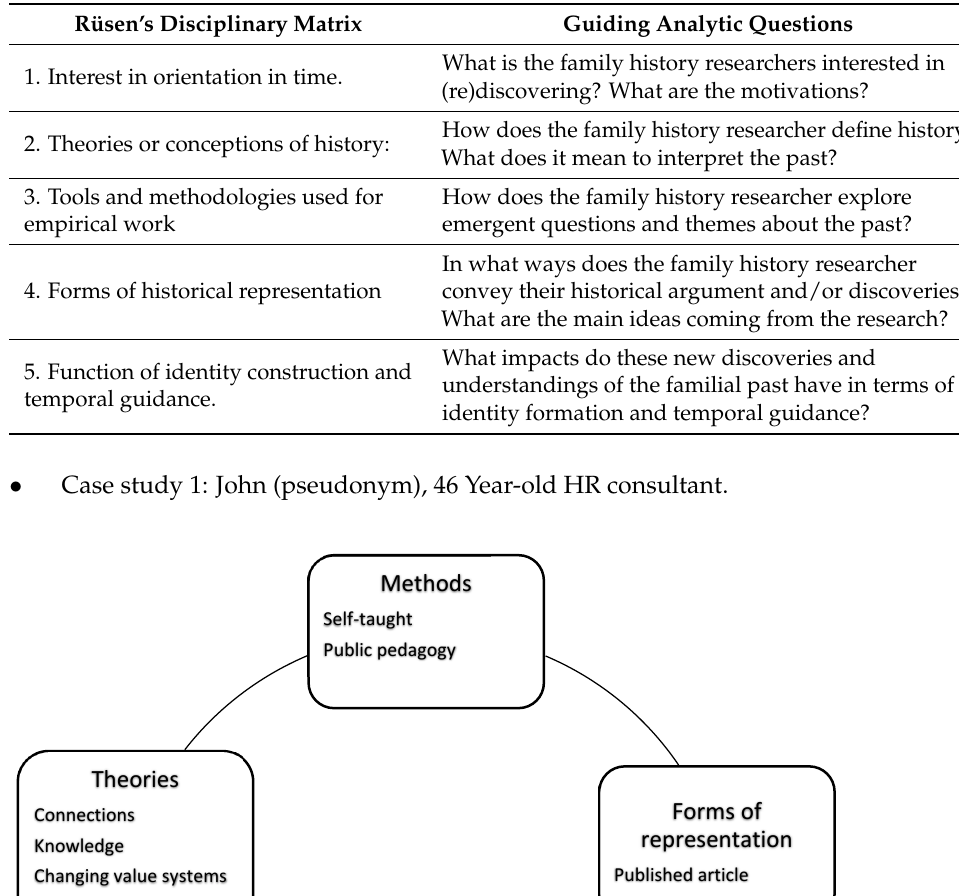
Table 3. Guiding analytic questions in alignment with the Disciplinary Matrix.